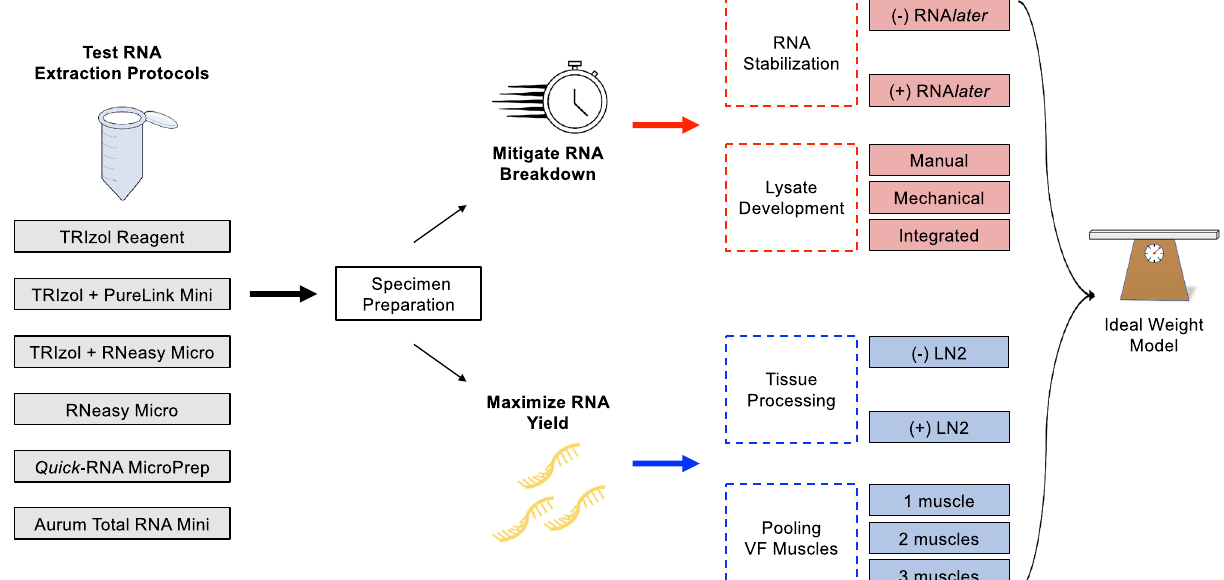
Figure 1. A schematic diagram of the experimental steps for high-quality RNA extraction from the vocal fold (Table 1). Though increased tissue pooling ( pt = 2) resulted in a statistically significant difference in the overall A 260 /A 280 ratio ( P < 0.0001), the increase in total RNA yield ( P > 0.99) was nonsignificant (Table 1). This kit was discarded due to the discrepant RNA quantity and purity across assays (Table 1). TRIzol reagent. Trizol reagent (Invitrogen) yielded significantly higher total RNA quantities using individual ILMs compared to the results achieved using the spin-column kits (2458.84 ± 2070.48 ng, Quick -RNA, P = 0.05;